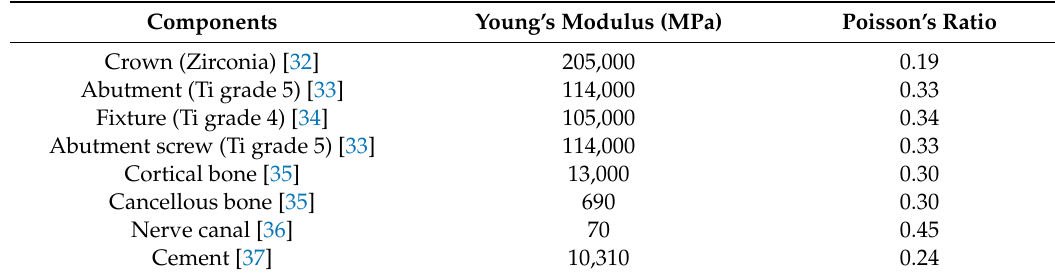
Table 1. Material properties applied in the finite element analysis (FEA) models.